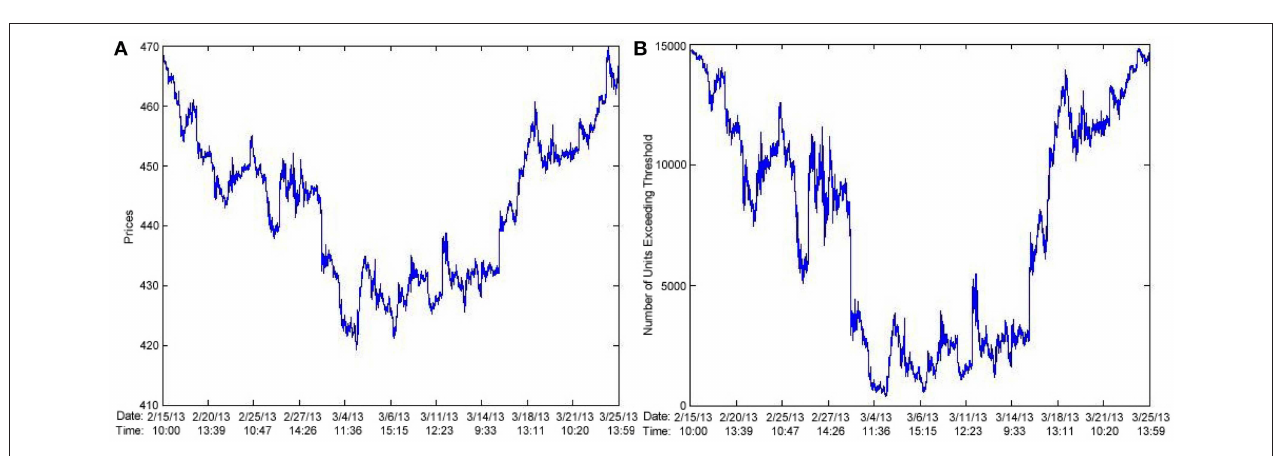
FIGURE 18 | (A) AAPL prices. (B) Output of SSR applied to AAPL prices.